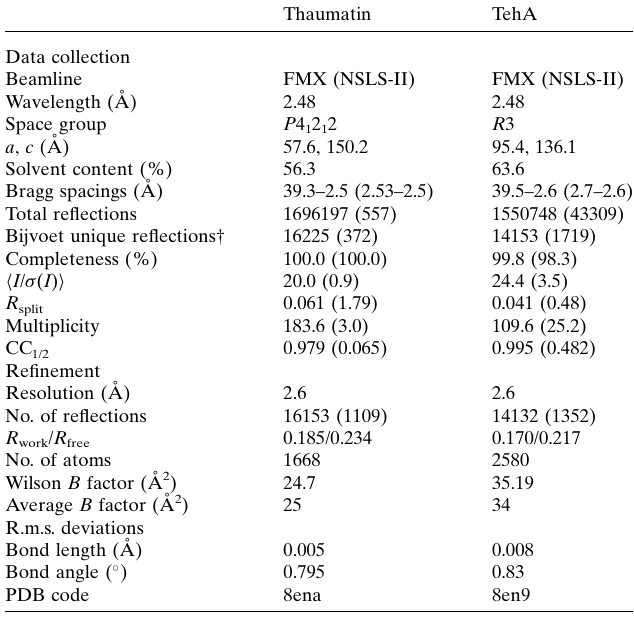
Table 1 Data collection and refinement